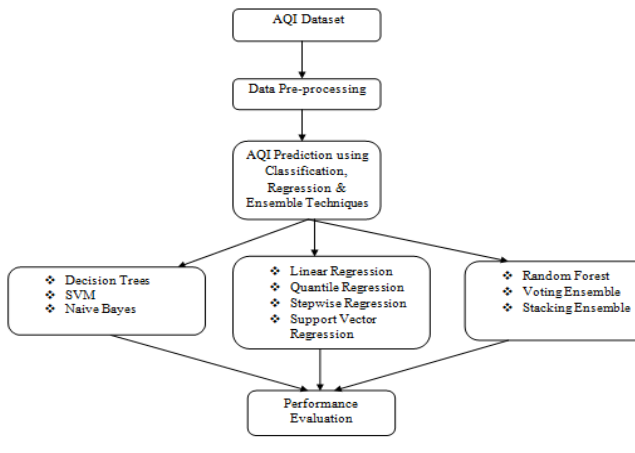
Figure 3. AQI Prediction